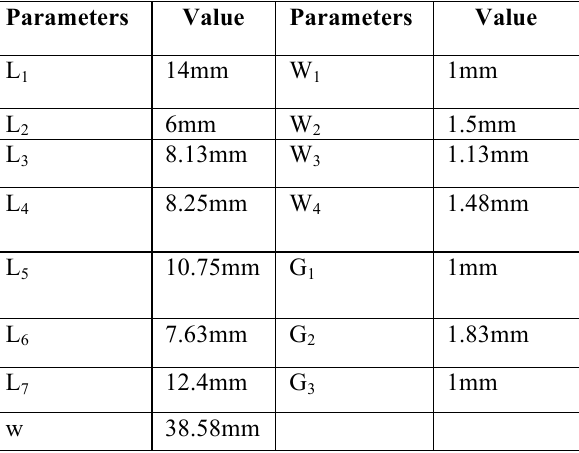
Table 1: Dimensions for the proposed antenna